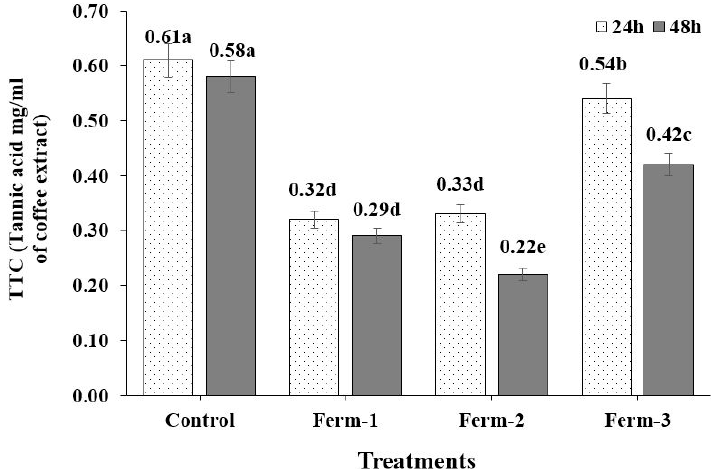
Figure 9. Total tannin contents (tannic acid mg/mL of coffee extract) of fermented coffee. The bars with different letters indicate a significant difference ( p < 0.5) among treatments.